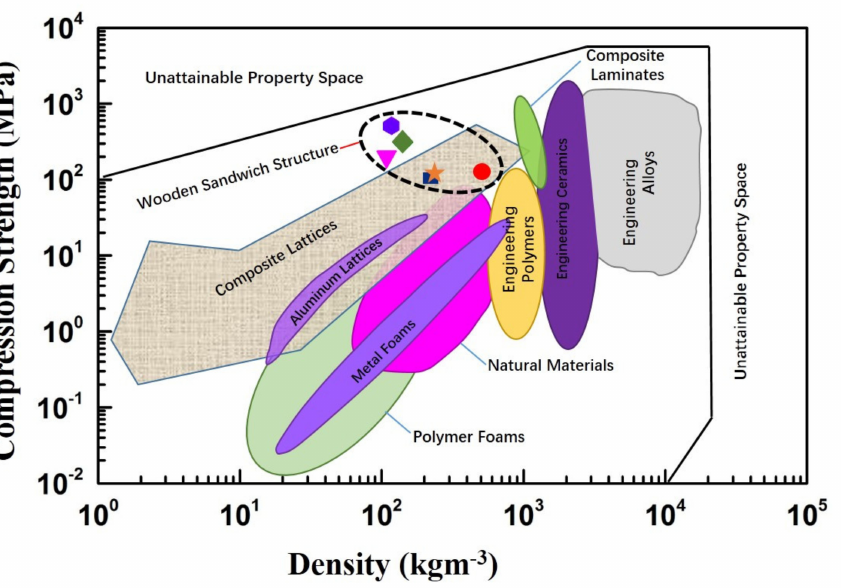
Figure 16. Relationship between compressive strength and density of wood-based sandwich structure